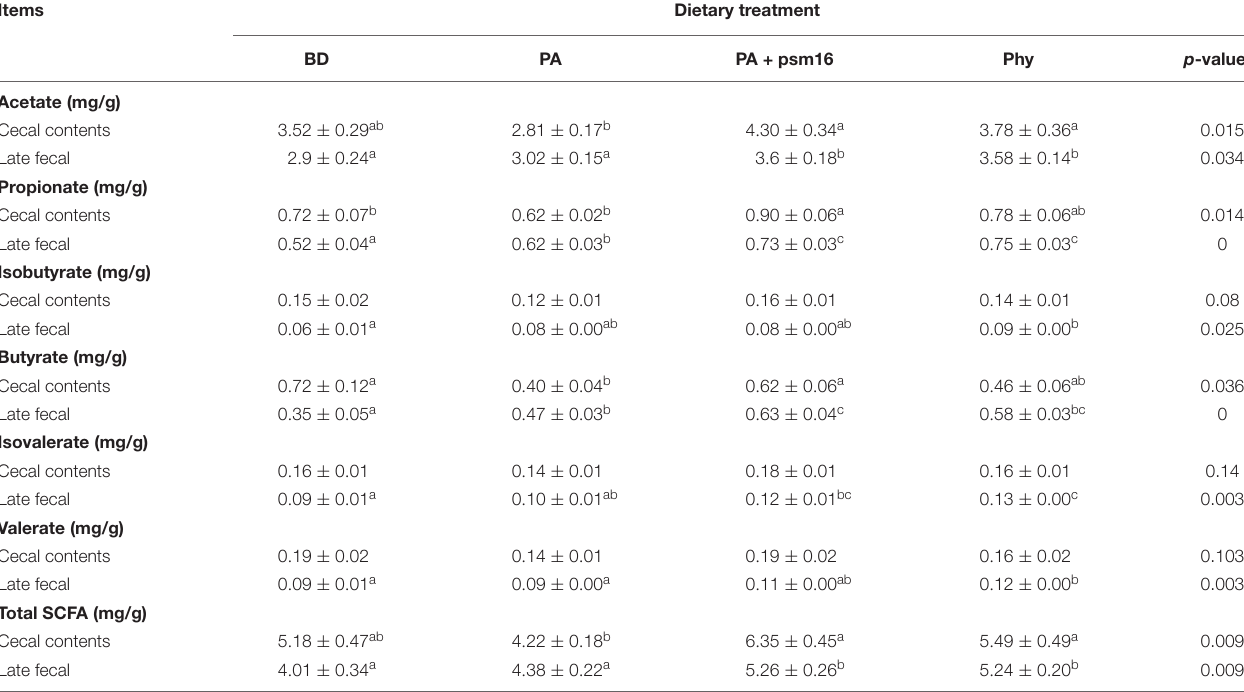
TABLE 2 | Effects of strains and PA on the levels of SCFA in the cecum and feces (mean ± SEM, n =